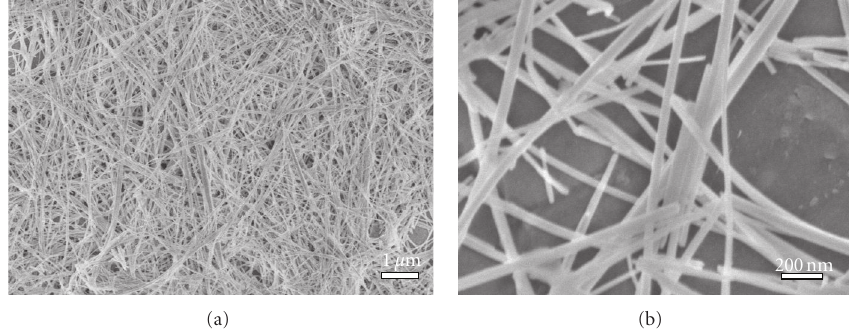
Figure 2: SEM images of the composite Bi 2 O 3 -Bi 2 CrO 6 nanowires: (a) low magnification; (b) high magnification.